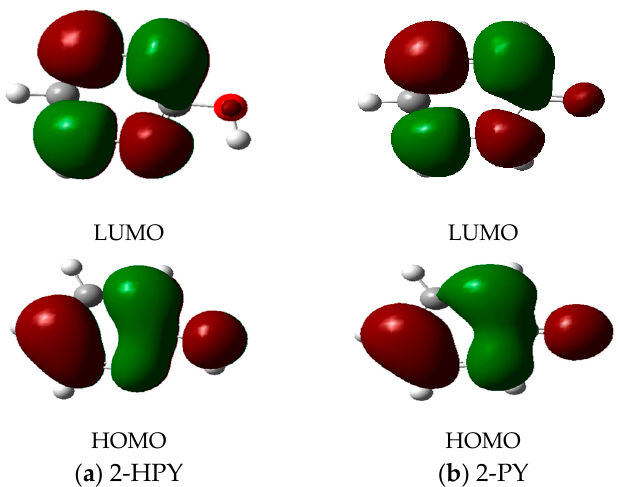
Figure 4. Frontier Molecular Orbitals of ( a ) 2-Hydroxyprydine (2-HPY) and ( b ) 2-pyridone (2-PY) which were calculated by using CAM-B3LYP/aug-cc-pvdz level of theory.